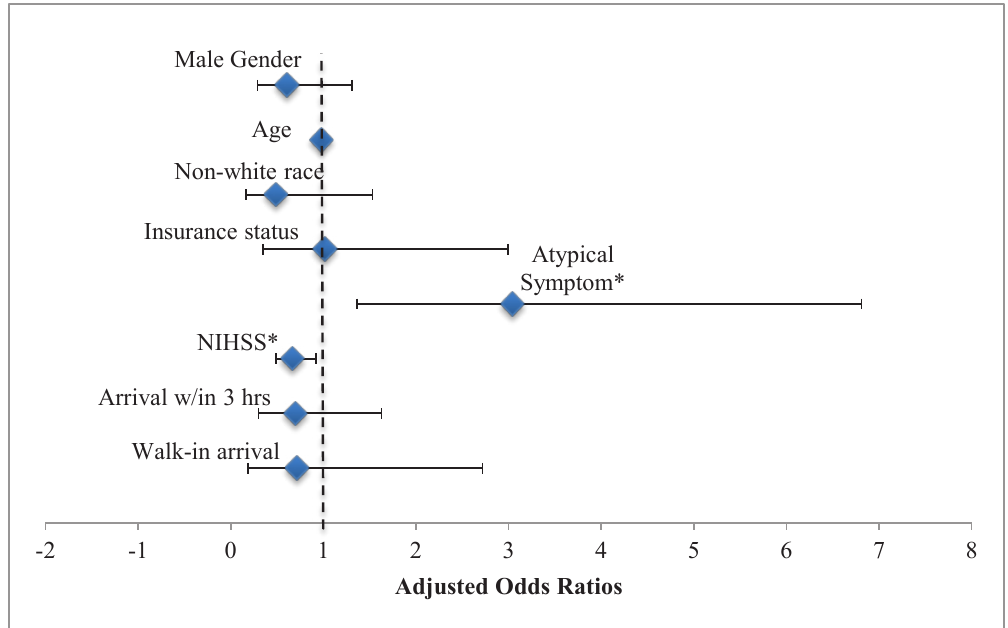
Figure 2. Adjusted odds of triage as ESI 3 compared to ESI 1 or 2 are displayed. NIHSS , National Institute of Health Stroke Scale Predictors are male gender, age, non-white race, insurance status, presence of atypical symptom (*p=0.007), NIHSS score as a continuous variable transformed using square root (*p=0.013), walk-in arrival compared to ambulance arrival, and arrival within 3 hours of symptom onset. Model fit was tested using Hosmer–Lemeshow goodness-of-fit test, (χ2= 15.7,